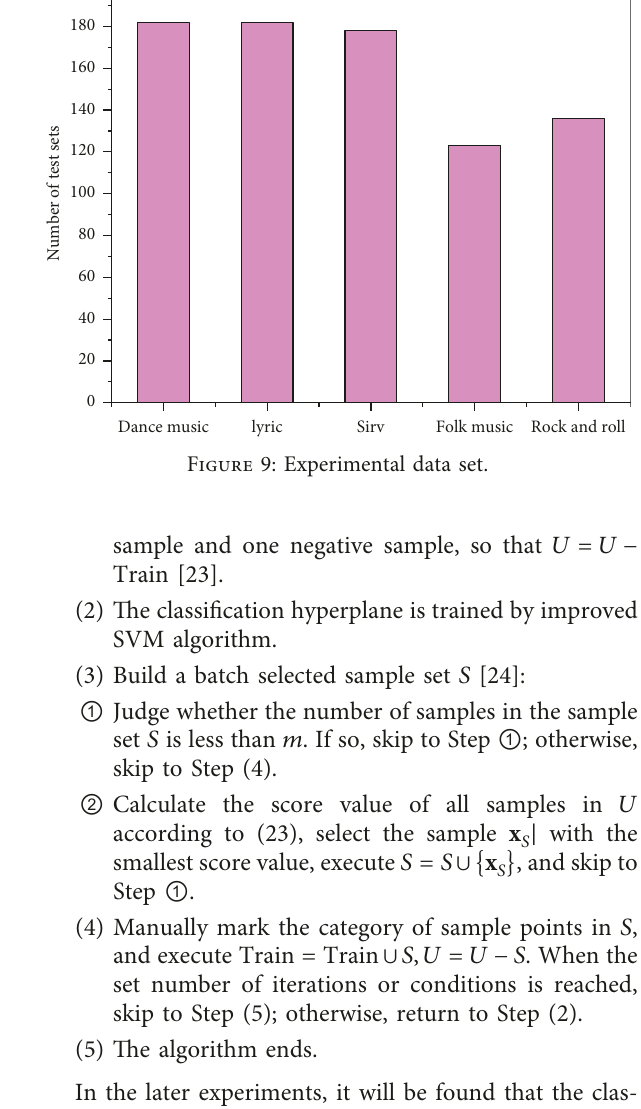
Table 2: Experimental data set.